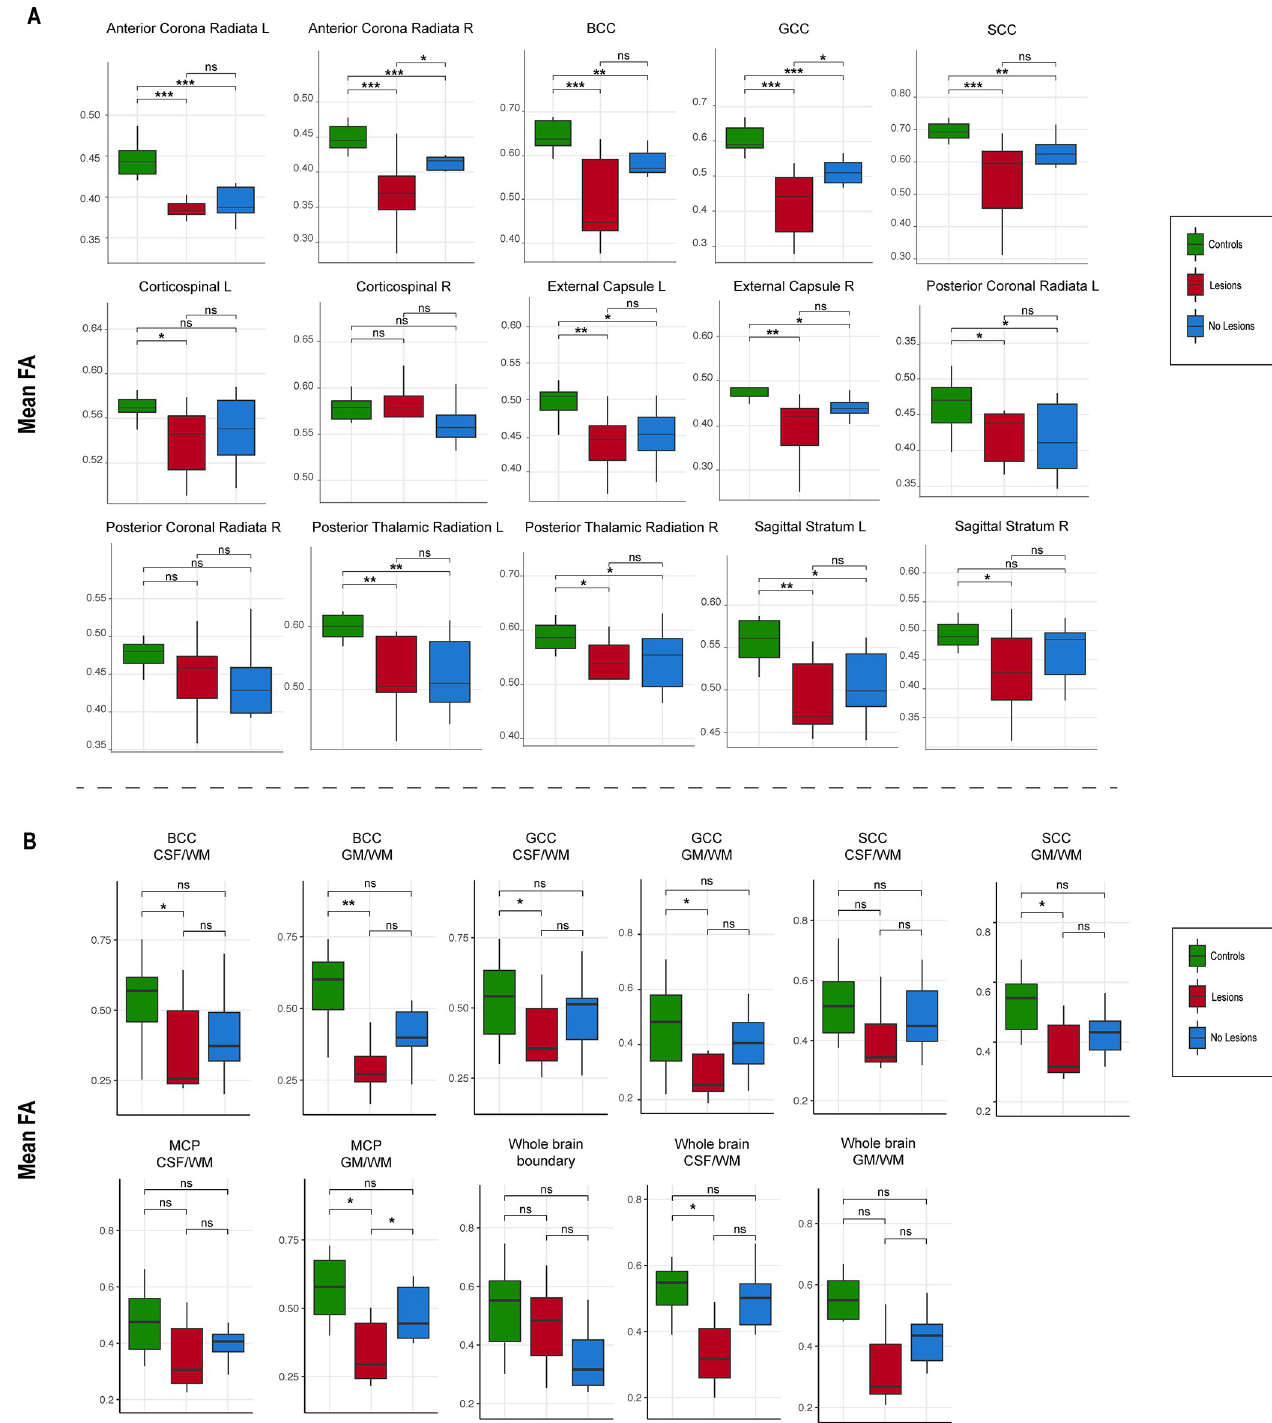
Fig 9. Tract-specific mean FA value. Comparison in 3 groups: healthy controls (green), TBI with lesions (red), and TBI without lesions (blue). A) whole tract segmentation, B) boundary of tracts segmentation. A subset of tracts is considered in this analysis, mainly when at least one of the bilateral tracts showed a difference. Ns = non-significant, BCC = boundary of the corpus callosum, GCC = genu of the corpus callosum, SCC = splenium of the corpus callosum, CSF/ WM = boundary of the CSF and the WM, GM/WM = boundary of the GM and the WM. � p < 0.05, �� p < 0.01, ��� p < 0.001.